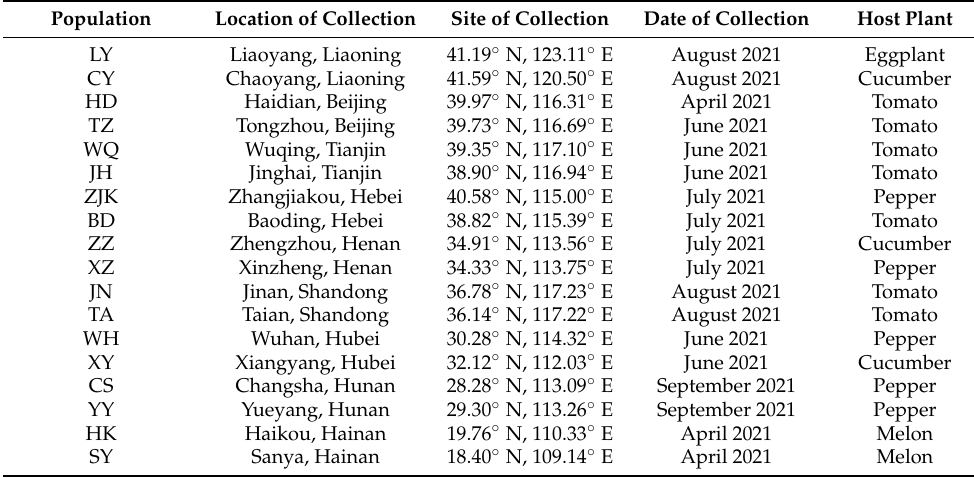
Table 1. Information of field-collected B. tabaci samples from